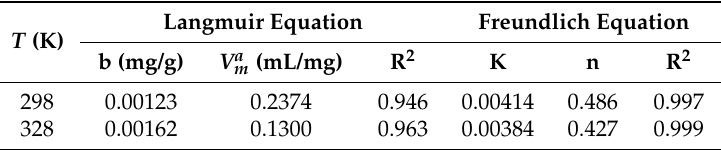
Table 3. Fitting parameters of Langmuir and Freundlich adsorption isotherm equations. Langmuir T (K)